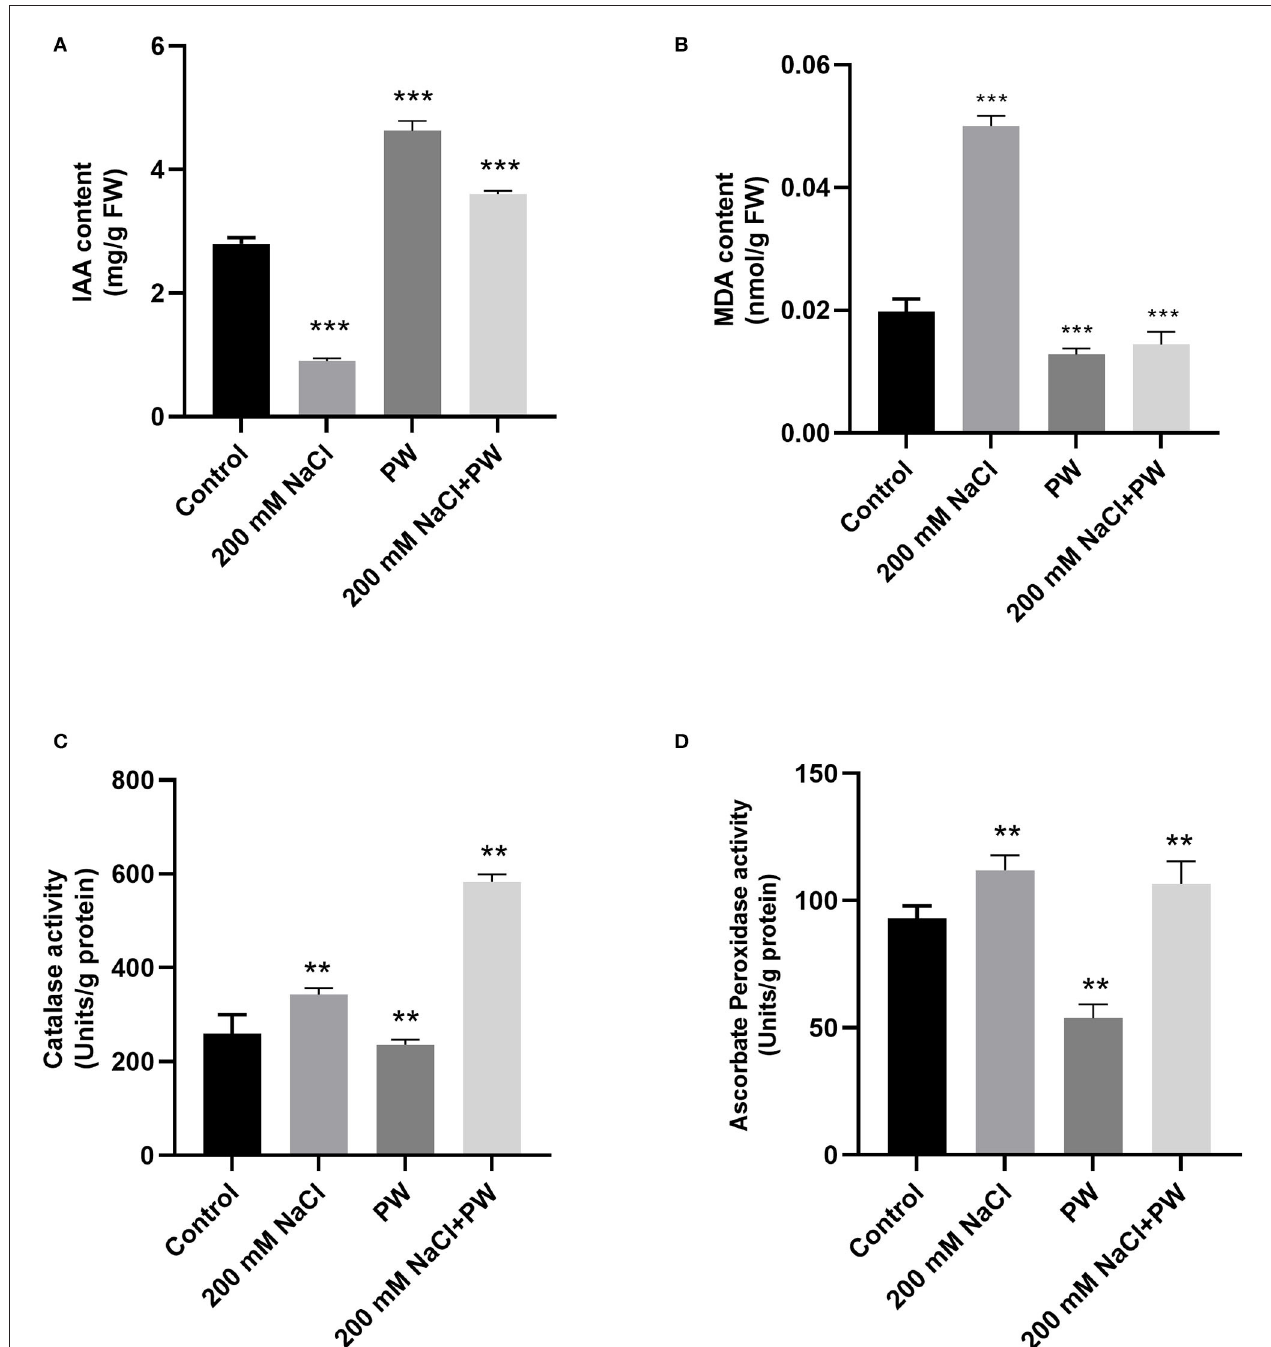
FIGURE 5 | Treatment of maize with S. lycopersici (PW) under normal and salt-stressed conditions. (A) IAA level, (B) MDA content, (C) catalase, and (D) ascorbate peroxidase. Bars indicate mean ± standard error from three replicates at a significant level of p ≤ 0.05. FW, fresh weight.